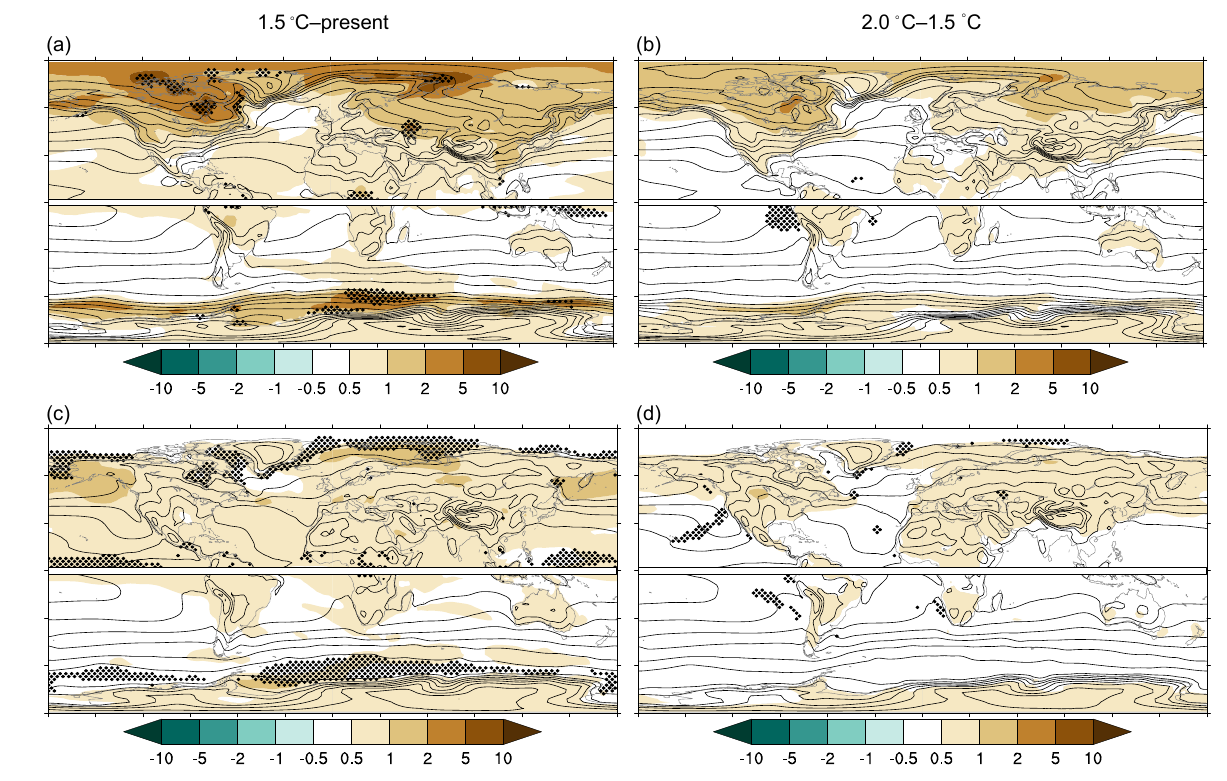
Figure 1. Multi-model mean response of surface air temperature for 1.5 ◦ C–PD (a, c) and 2.0–1.5 ◦ C (b, d) . Panels (a) and (b) show winter (Northern Hemisphere DJF, Southern Hemisphere JJA) responses (shading; units K) along with the climatology (contour interval 5K) for the (a) PD and (b) 1.5 ◦ C experiments. Panels (c) and (d) show the same for summer (Northern Hemisphere JJA, Southern Hemisphere DJF) along with the climatology (contour interval 5K) for the (c) PD and (d) 1.5 ◦ C experiments. There is model consensus on the sign of the response everywhere. Black dots mask out regions where there is model dependence; i.e. the models do not agree on the magnitude of the response ( f 2 > 1; see Sect. 2.2 for